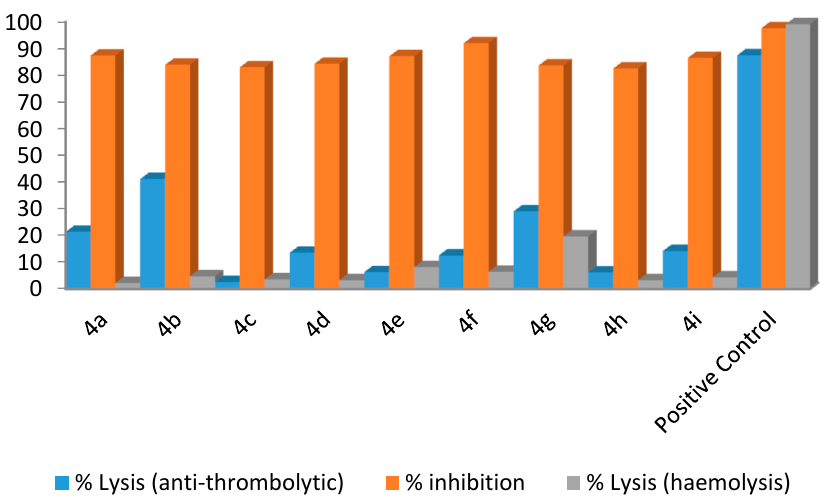
Figure 4. Anti-thrombolytic, biofilm inhibition and haemolytic activities of compounds ( 4a – 4i